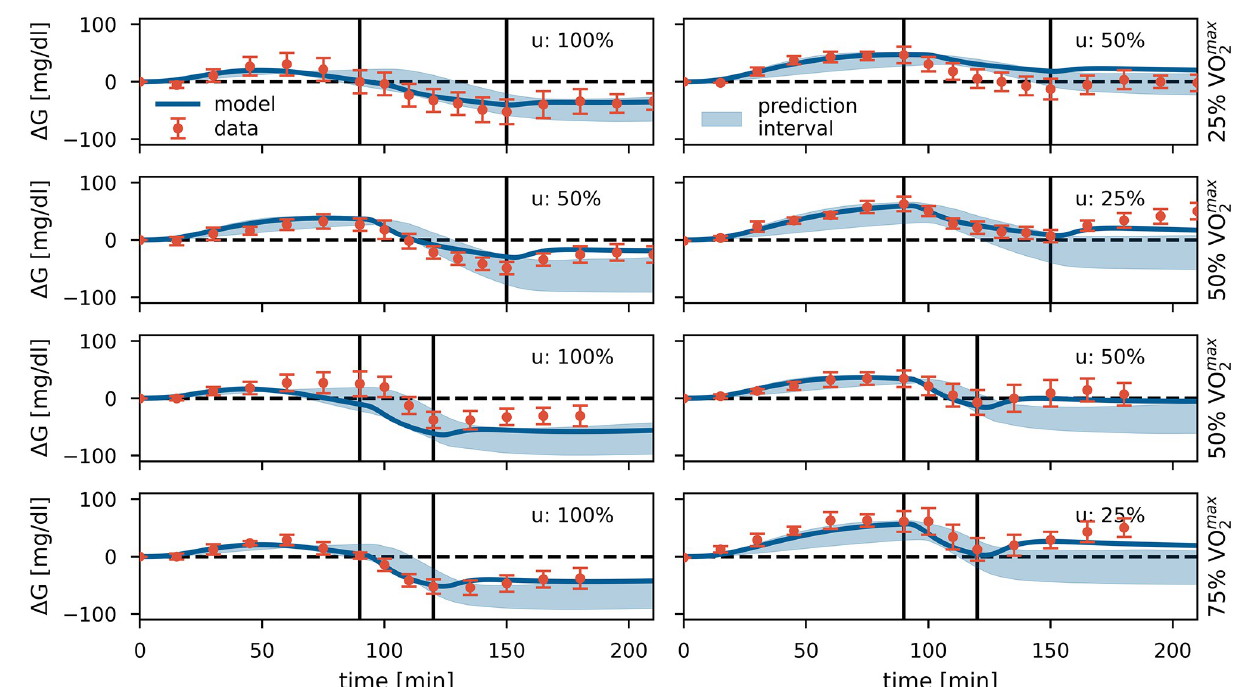
Fig 3. Model validation. Data (mean ± SEM, n = 6) [47] and model predictions for validation study (1). PA sessions are marked by vertical lines. PA was performed at different intensities (25%, 50% and 75% VO max ) for durations of 30 or 60 min. A meal was consumed 90 min prior to PA, with a meal 2 insulin bolus u of 100%, 50% or 25% of the full dose. The shaded areas show the 95% prediction intervals of the T1D model (V1), and solid BG trajectories display the tuned model ( b = 1.83 � 10 − 6 , q 1 = 2.93 � 10 − 6 , q 2 = 2.93 � 10 − 6 ). Meal parameters f and τ m = 105 min were determined from glucose levels at rest.